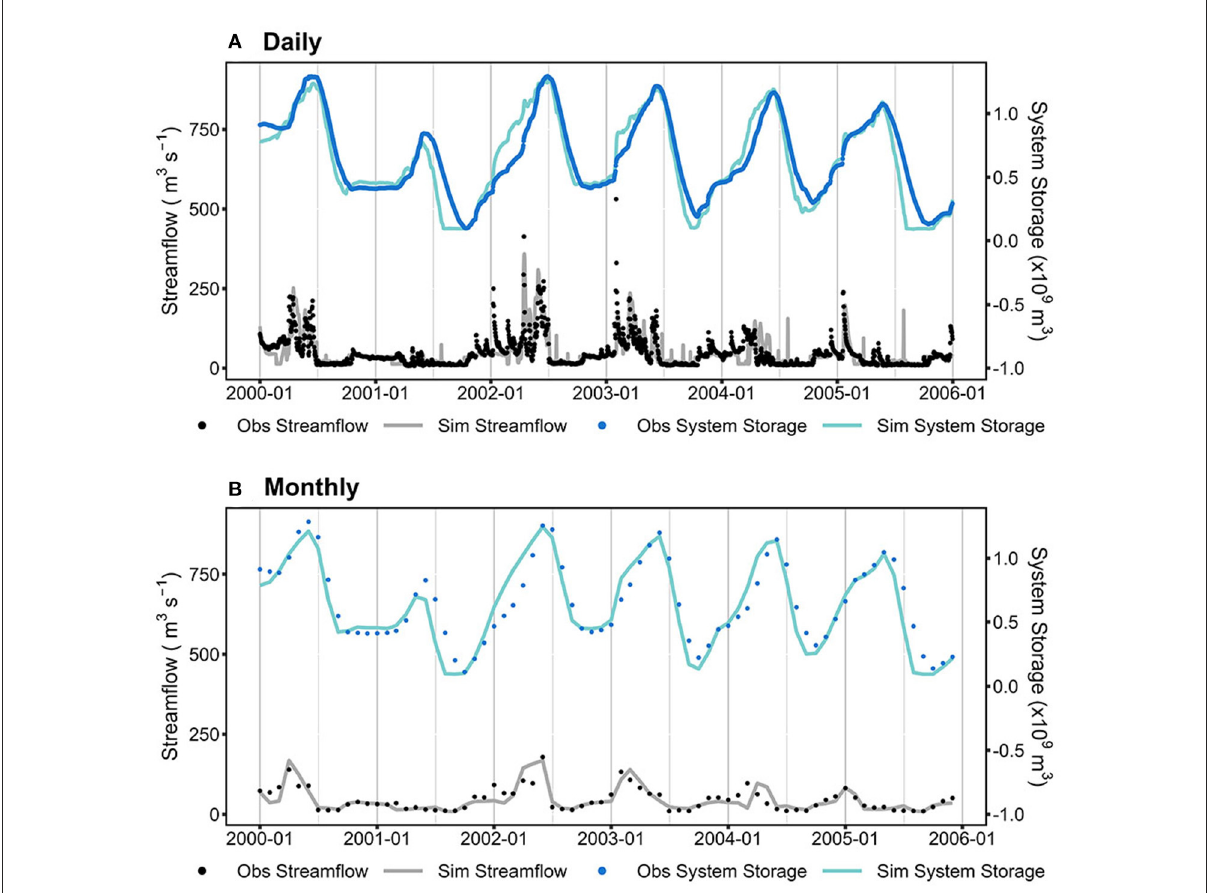
FIGURE5 Simulations and observations of total reservoir storage and streamflow at Parker station for (A) daily values; and (B) average monthly values.